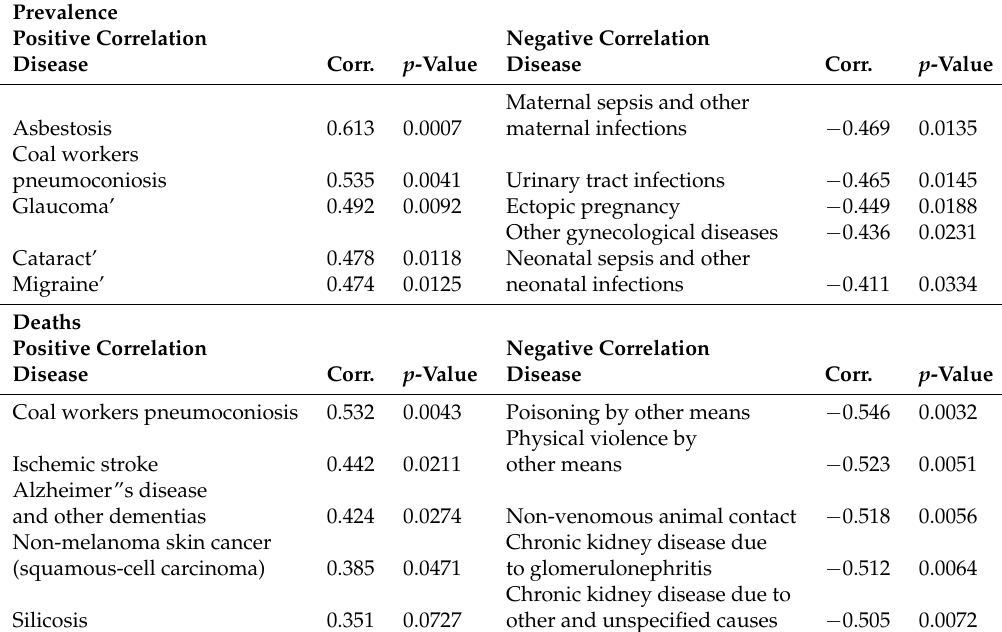
Table A2. This table shows the correlation coefficients and related p-values between prevalence or percentage of all deaths and the numbers of slum dwellers per km 2